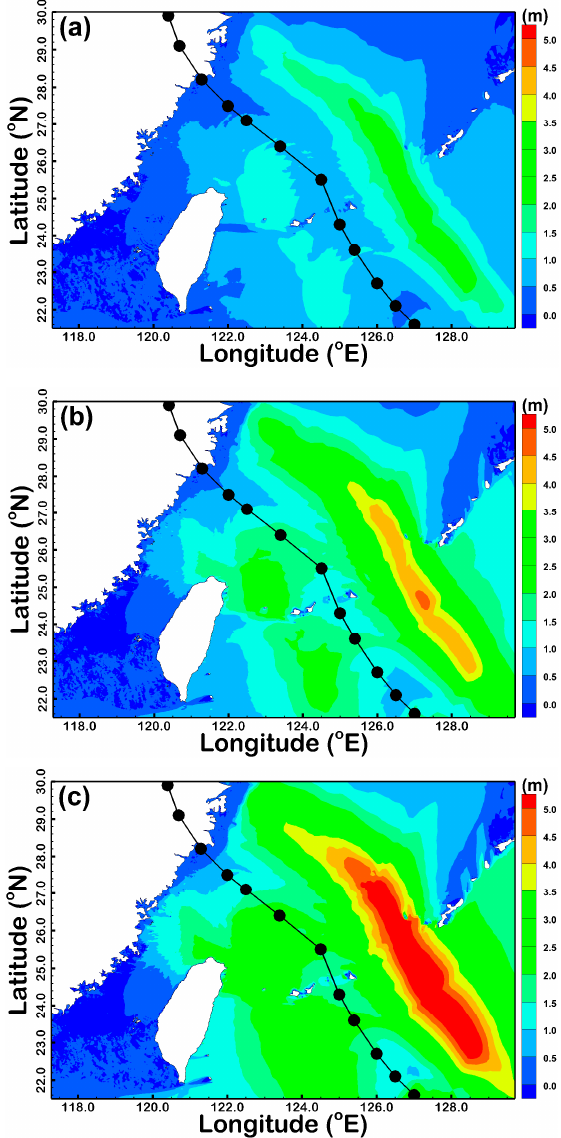
Figure 8. Spatial distribution of the difference in maximum SWH using the winds from ( a ) H_5R max and H_4R max , ( b ) H_6R max and H_4R max and ( c ) H_7R max and H_4R max during the passage of Super Typhoon Lekima in 2019.